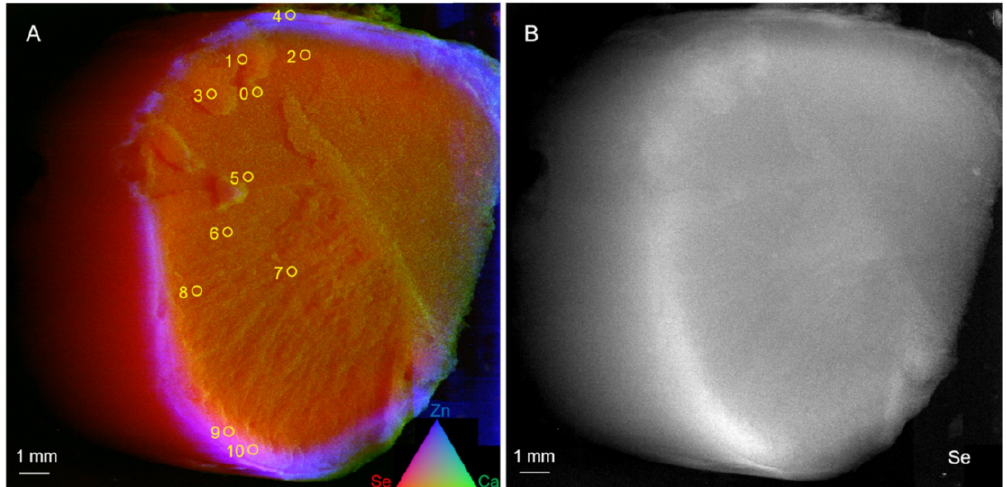
Figure 2. Micro X-ray fluorescence elemental distribution maps of a cross section of Brazil nut #12 (48 mg Se kg − 1 , Table 1). Se is shown in red ( A ) or white ( B ). Panel A also shows Zn in blue and Ca in green. Micro X-ray absorption near-edge structure spot locations are shown as numbered yellow circles; speciation results are shown in Table